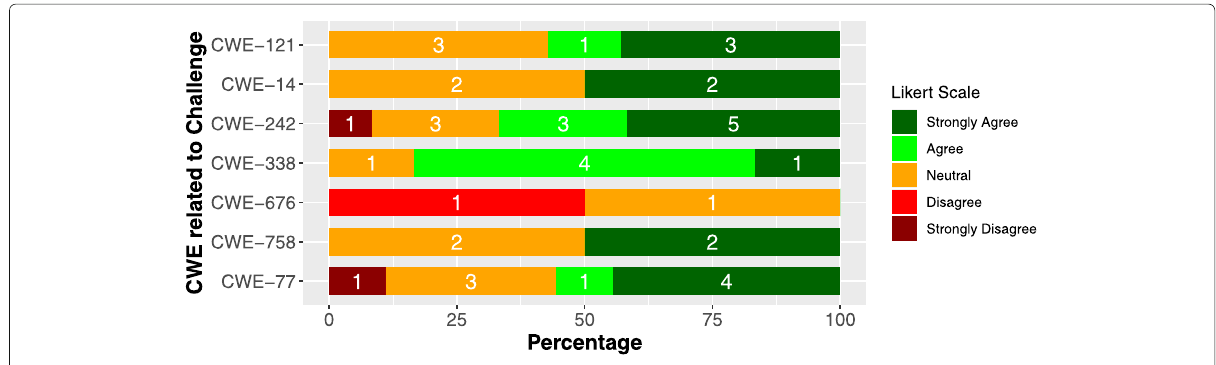
Fig. 12 Evaluation of Challenges in Sifu Platform - Survey S 1 ,